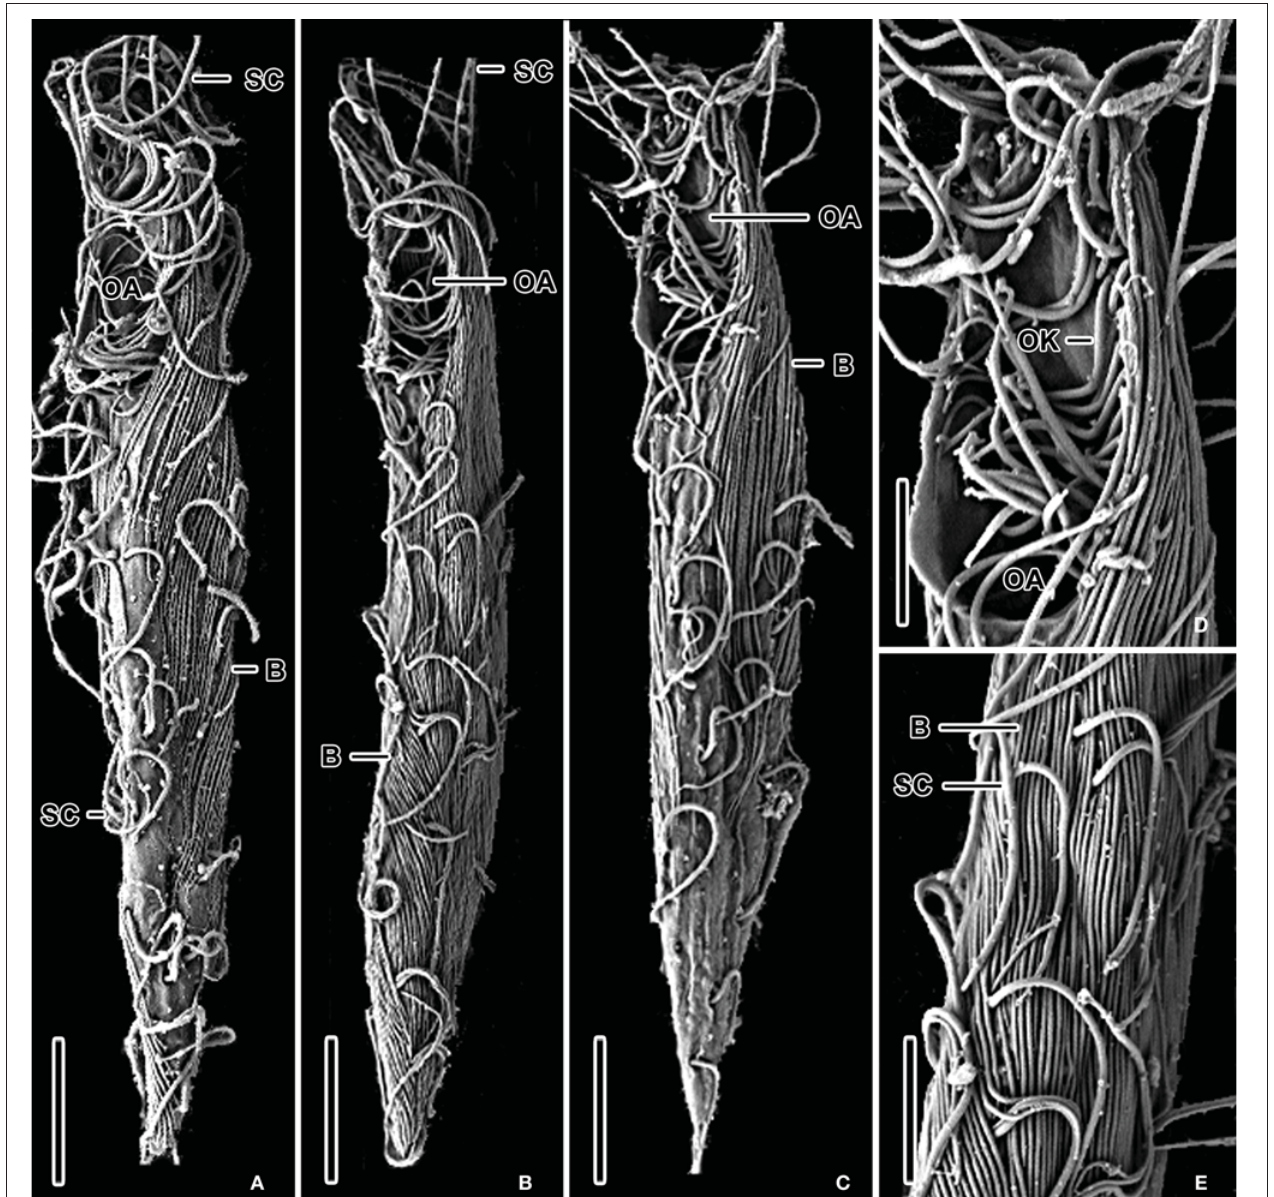
FIGURE 2 | SEM micrographs of various bacteria/ciliate morphologies from the halocline of the Discovery basin in the Mediterranean Sea. Ventrolateral views (A–C) of narrowly fusiform ciliates displaying epibiotic filamentousbacteria which cover almost the whole ciliates’ body. Detail of oral apparatus (D) of a specimen shown in (C) . There is a single oral kinety, which